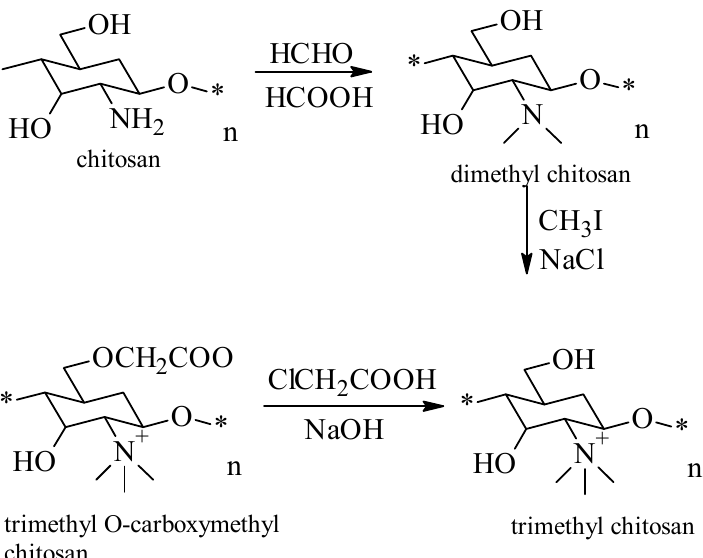
Figure 2. Scheme for the preparation of the trimethylated derivative of chitosan. “*” means that this units binds to other units through glycosidic bonds.